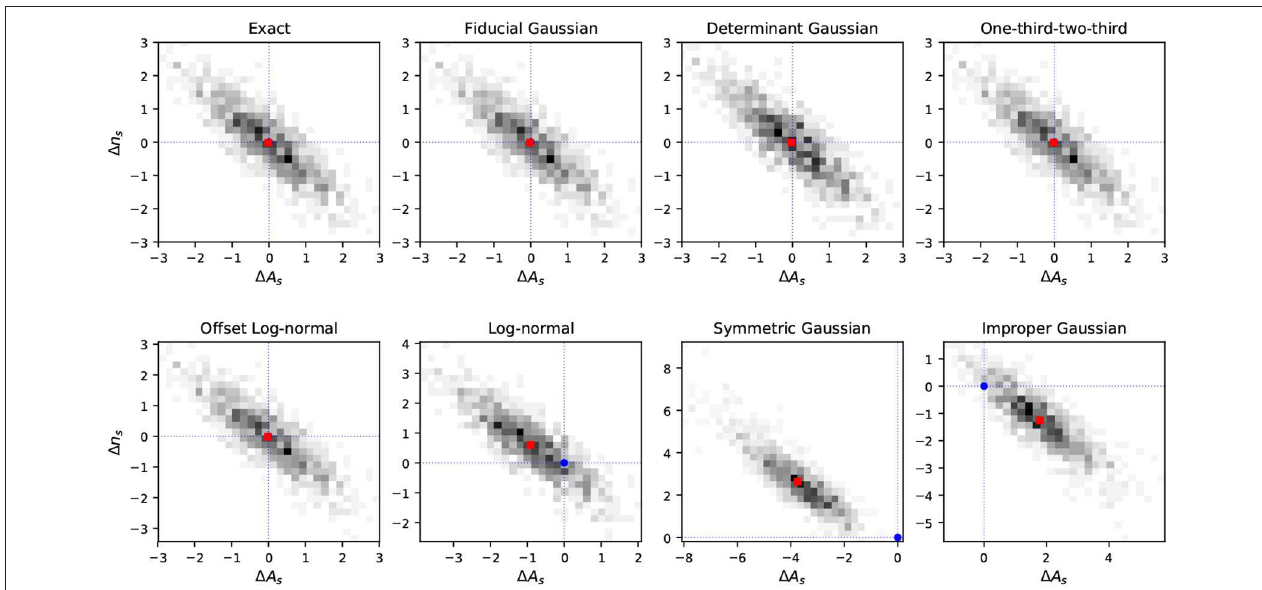
FIGURE 1 | 2D histograms of the biases on the parameters expectation values estimated from 1000 simulated full-sky maps of CMB temperature plus noise. As described in more detail in the text, the biases are computed with respect to the input parameter values and normalized to the 1 σ uncertainty associated to the p p i n ) /σ p , where p can be either A s or n s . The blue circle indicates a null bias, while the red square is the center of the distribution. Note that for parameter, 1 p ( ˆ = − the cases plotted in the first row the two almost completely overlap.